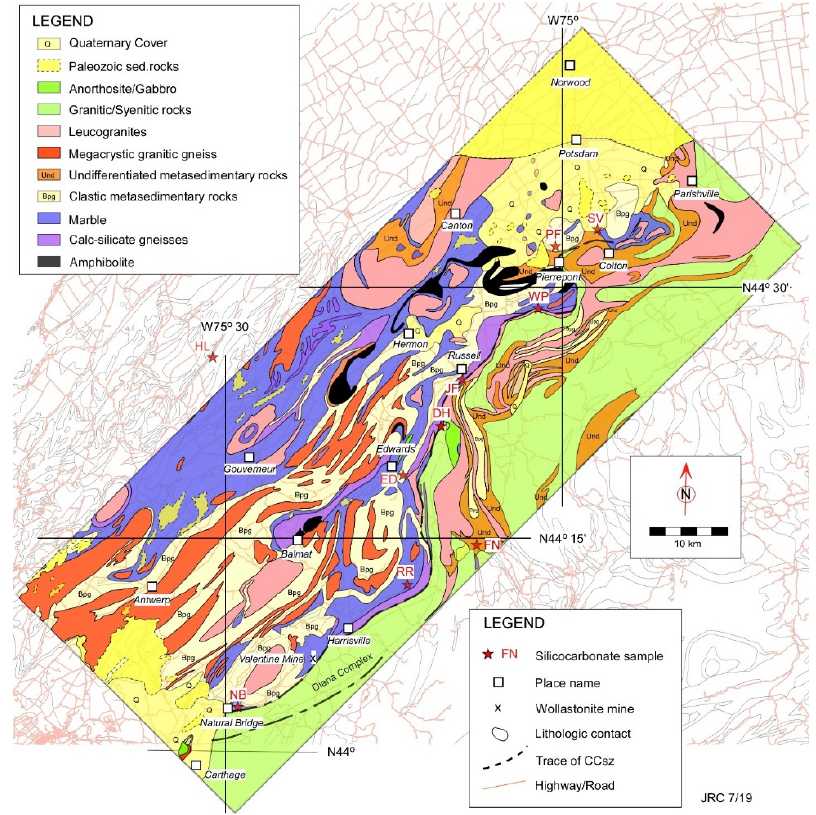
Figure 2. Simplified geological map of the boundary between the Adirondack Highlands and Lowlands after Isachsen and Fisher [11]. Red stars represent sample localities along the Carthage-Colton shear zone.